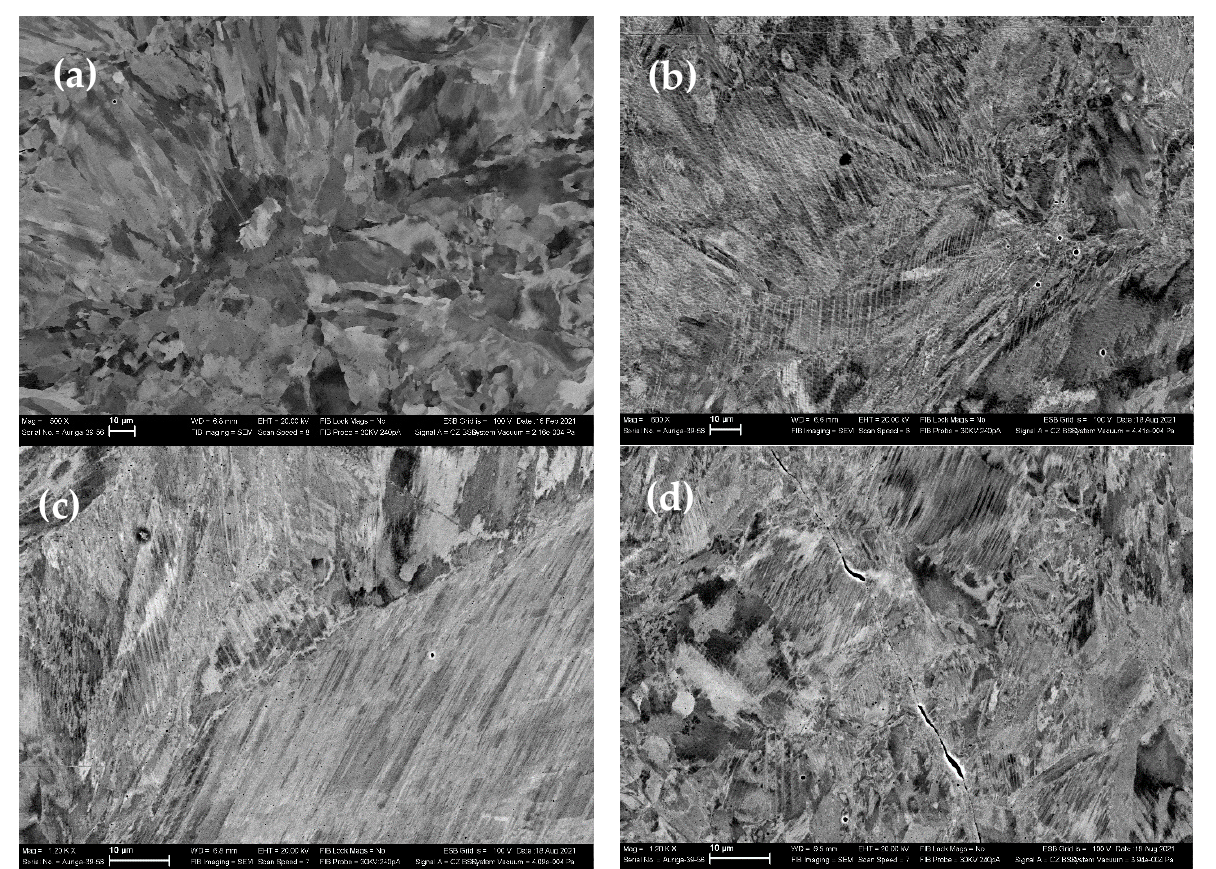
Figure 5. Microstructure of the studied samples, SEM images: ( a ) as-built; ( b ) 8 × 10 − 4 s − 1 , ( c ) 3 × 10 − 3 s − 1 , and ( d ) 2 × 10 − 2 s − 1 .